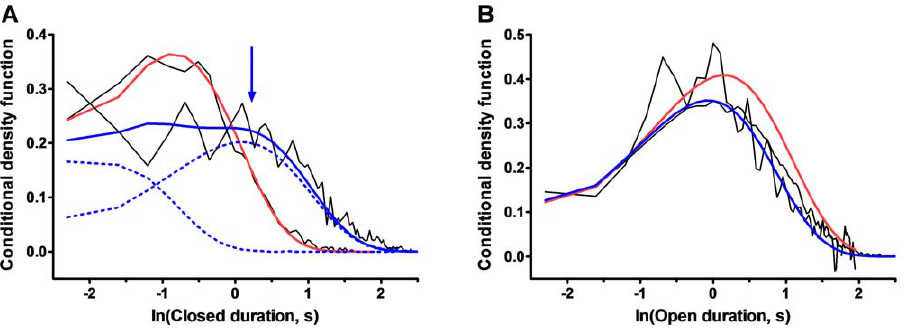
Figure 2. Intermolecular negative cooperativity in K ATP channel gating. A. In patches with N max =2, the conditional closed dwell time distribution of a K ATP channel when the other channel is closed (YC, fit to two exponential components, solid blue line) exhibits two kinetic components (dashed blue lines). The major component has a smaller mean than the mean closed dwell time when the other channel is open (YO, fit to one exponential component in red; a peak is not observed in the plot because the distribution is truncated by the sampling time). A second component in YC (blue arrow) lacks a corresponding component for comparison in YO because openings tend to terminate the longer events in this distribution (see Discussion S1). B. The two conditional density functions for open dwell times are the same within experimental uncertainty. XC, the conditional density function when the other channel is closed, fit to one exponential component in blue; XO, the conditional density function when the other channel is open, fit to one exponential component in